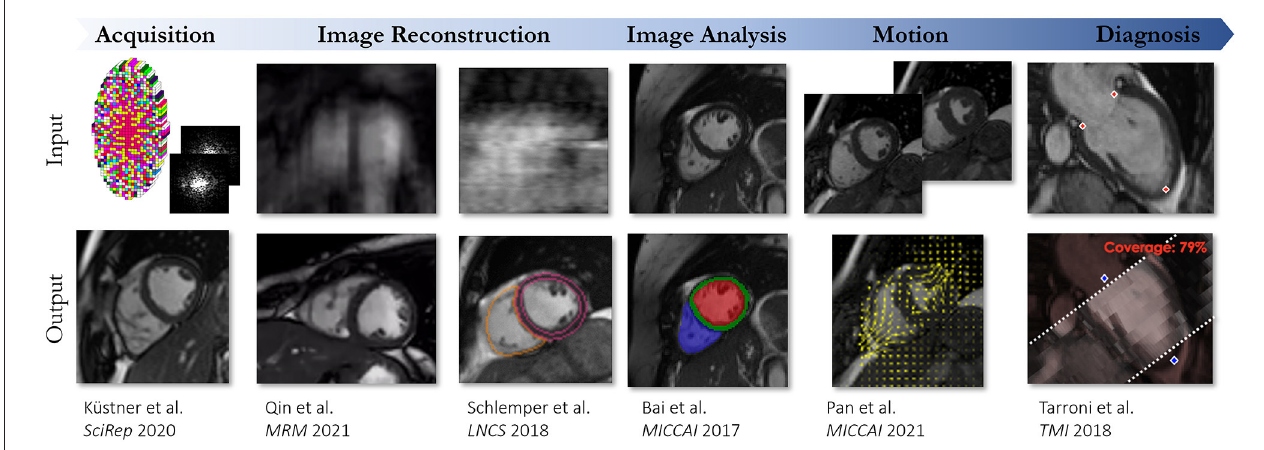
FIGURE 15 | Exemplary AI-assisted applications performed on cardiac CINE MRI ranging from acquisition over image reconstruction, analysis, motion to diagnosis. The respective inputs and output data is illustrated.